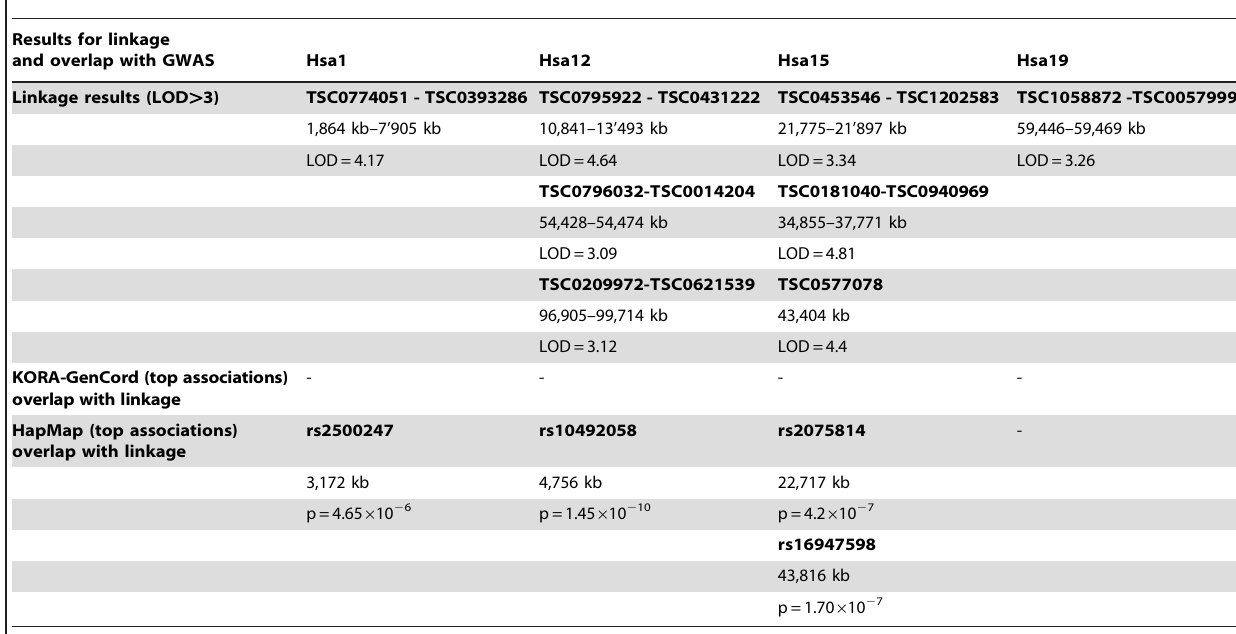
Table 4. Overlap between top hits from linkage and